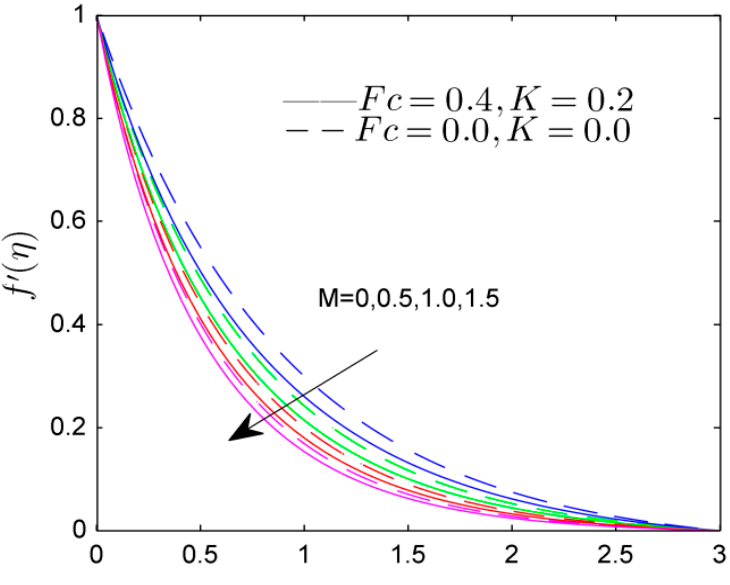
Figure 7. Effect of Weissenberg number (𝑊𝑖) on 𝑓 (cid:4593) (𝜂) when 𝐹𝑐 = 0, 0.4 and 𝐾 = 0, 0.4 .